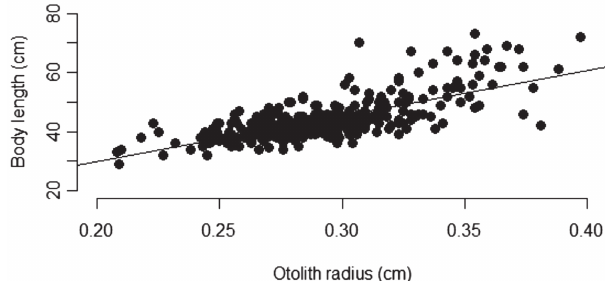
Fig. 4. Relationship between body length and otolith radius River basin. Tab. 2. Comparison of the length at capture and back-